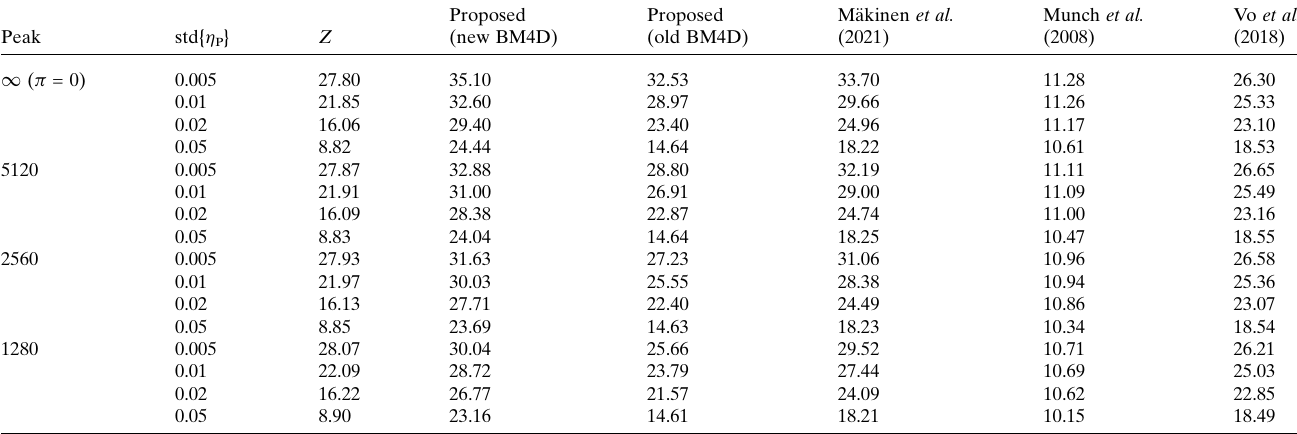
Þ(cid:10) as SNR ð ^ YY Þ = P